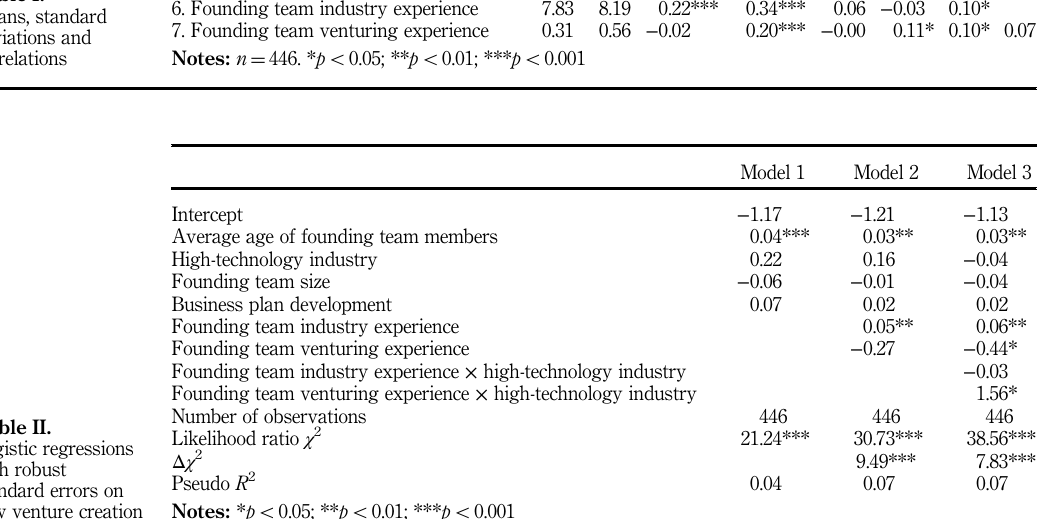
Table I. Means, standard deviations and correlations